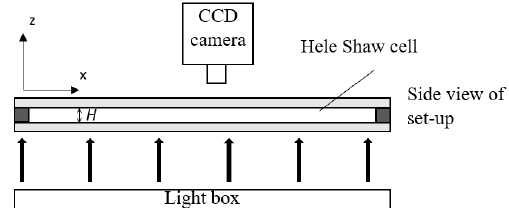
Fig. 1. Side view of the experimental setup. A horizontal Hele- Shaw cell with aperture H. The CCD camera acquires images of the intensity of light transmitted through the cell.